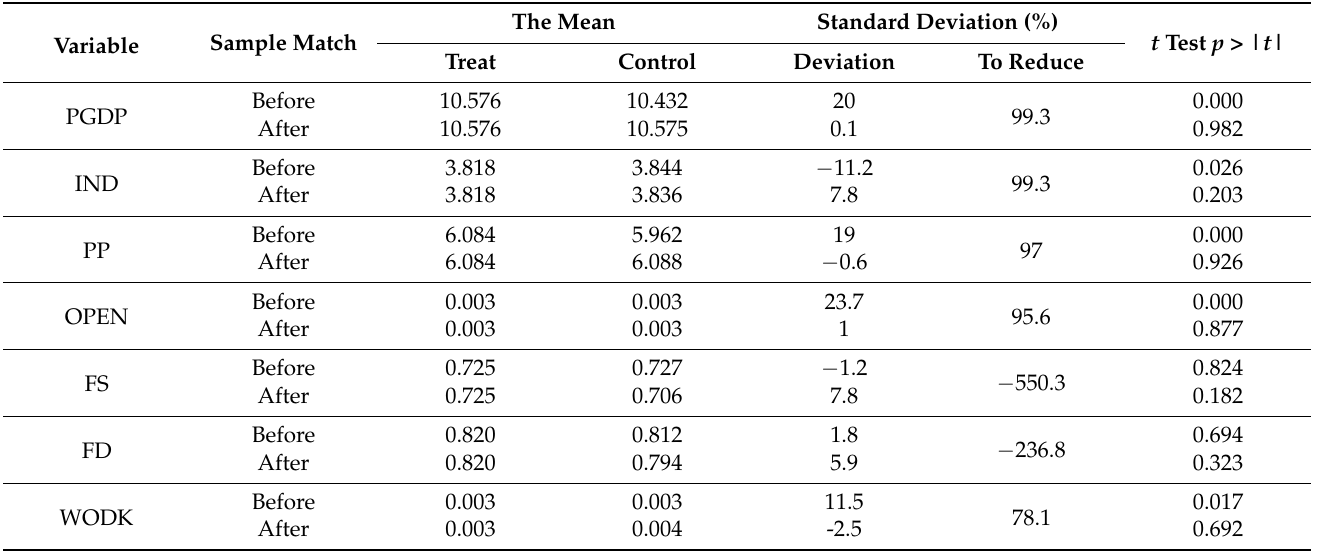
Table 2. Balance test of propensity score matching.